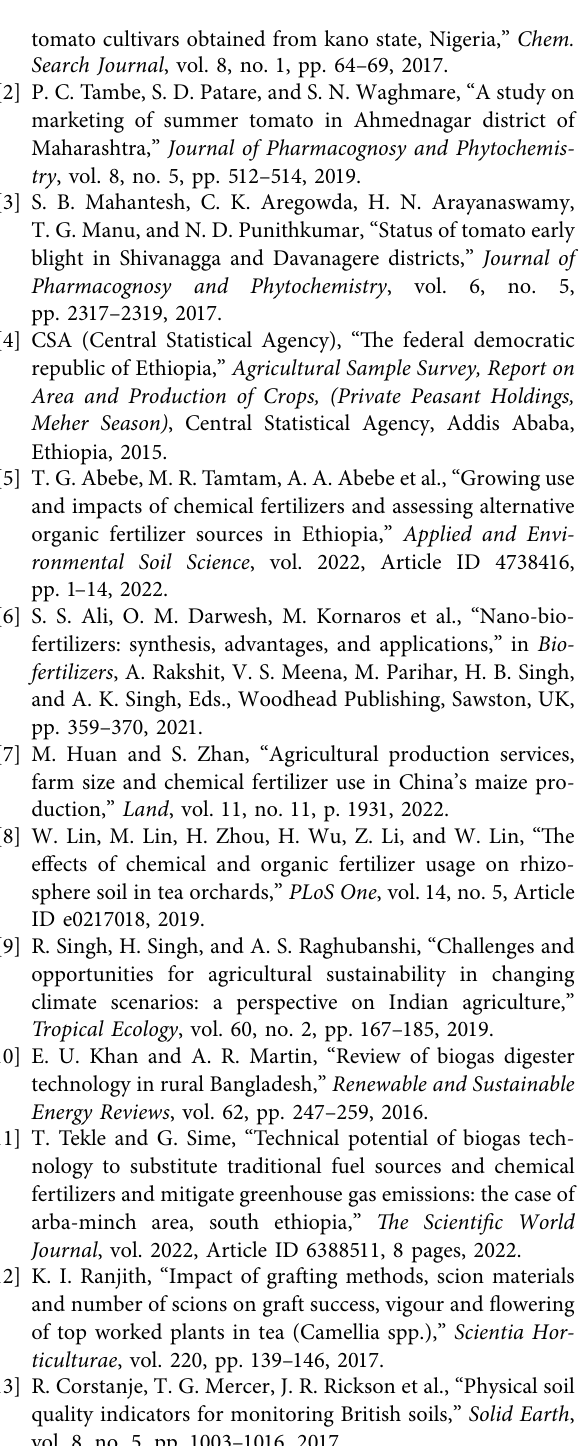
tomato cultivars obtained from kano state, Nigeria,” Chem.